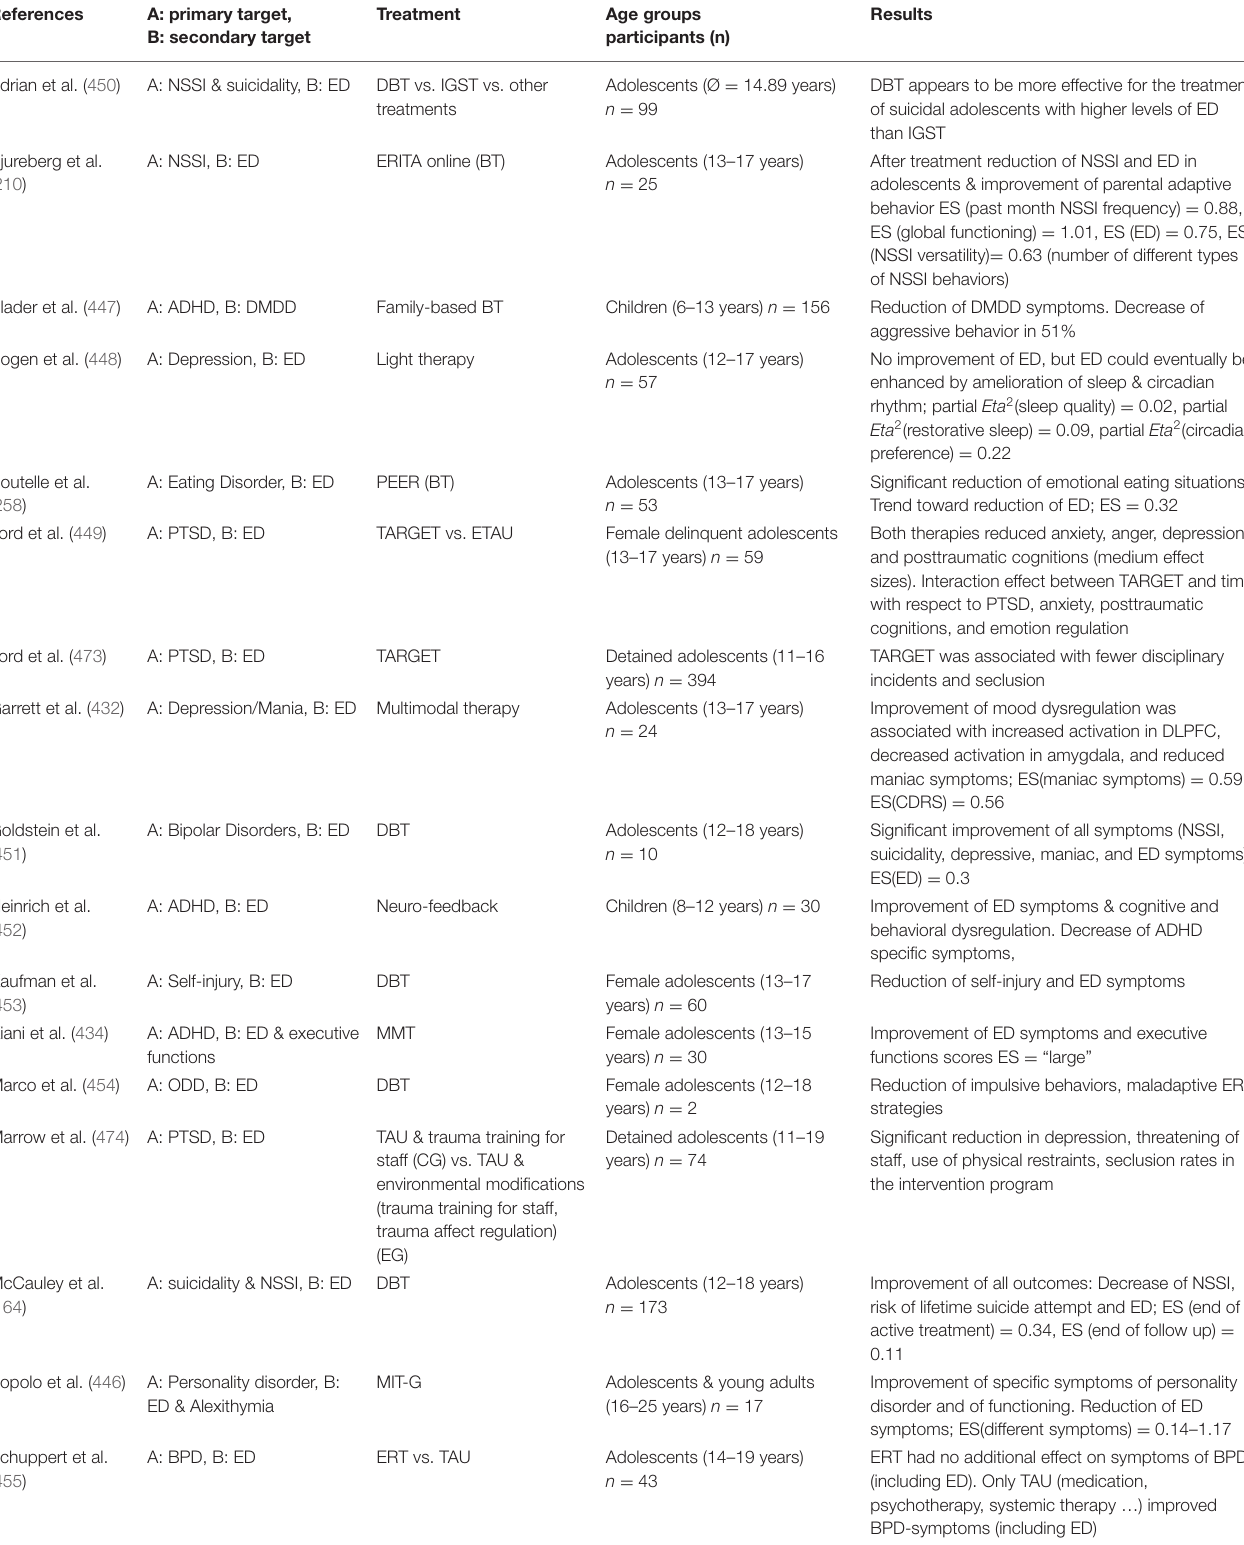
TABLE 2 | Clinical trials focusing on ED as secondary